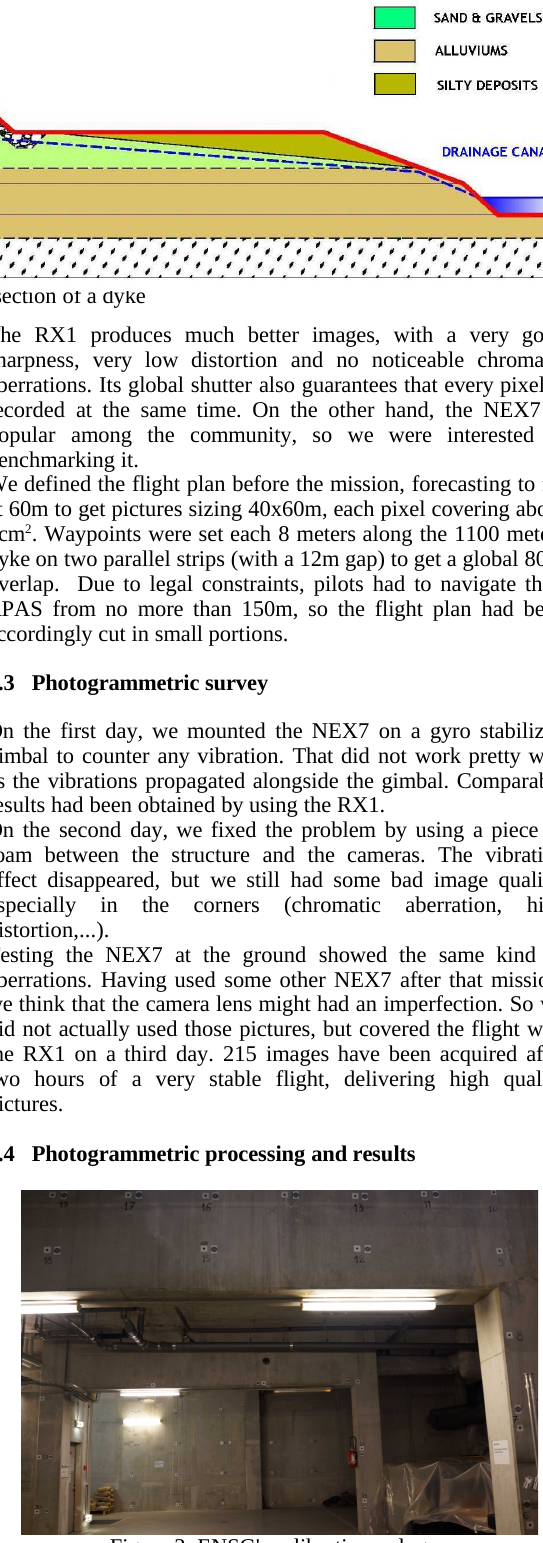
Figure 3: ENSG's calibration